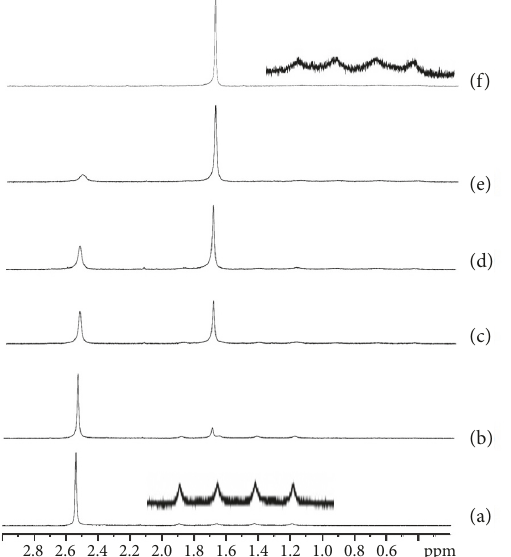
Figure 3: 1 H NMR titration of trimethylamine borane (1.0 mM) with (a) 0.00, (b) 0.17, (c) 0.50, (d) 0.67, (e) 0.83, and (f) 1.25 equiva- lents of CB [7] in D 2 O. B-H proton resonance shown